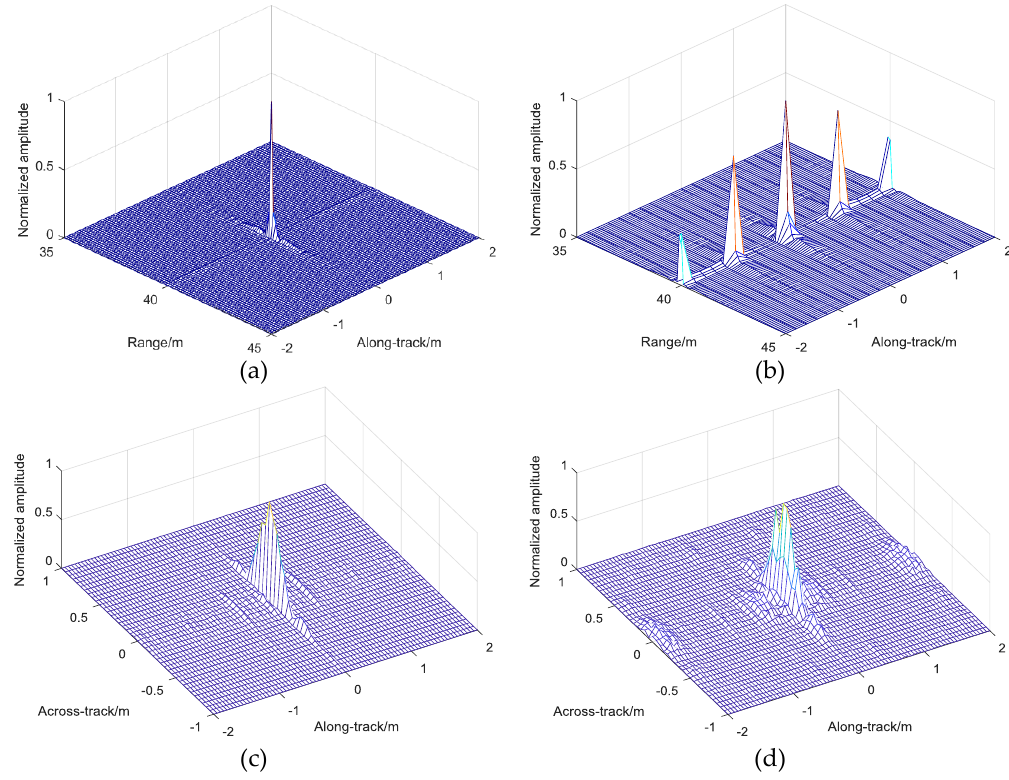
Figure 3. Grating lobe comparison between sampling intervals: ( a ) grating lobe of single element at sampling interval of 0.5D; ( b ) grating lobe of single element at sampling interval of 2.0D; ( c ) grating lobe of MBSAS at sampling interval of 0.5D; ( d ) grating lobe of MBSAS at sampling interval of equivalent value 5.0D.